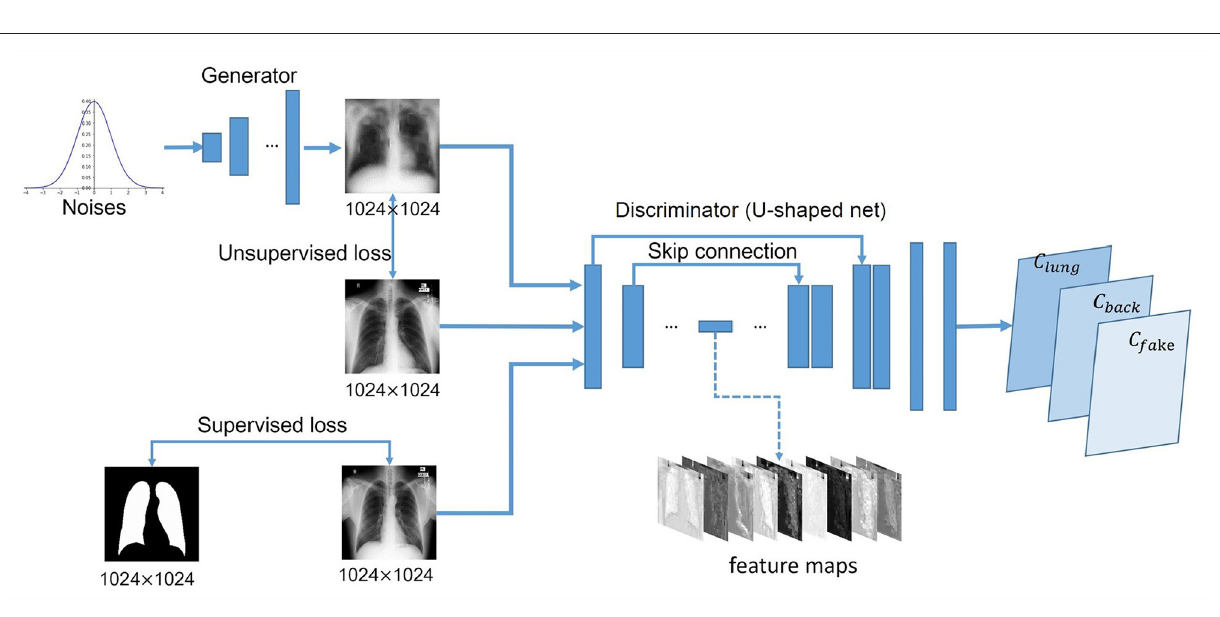
a distribution p g ( G ( z )) converging to the real distribution p ( x ) of the whole dataset consisting of annotated and unannotated